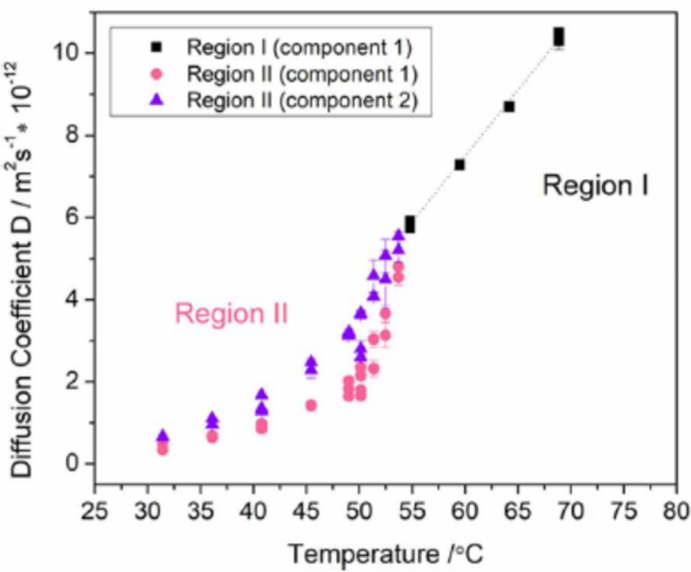
Figure 4. Diffusion coefficients from the hybrid ceramic-polymer electrolyte as a function of tempera- ture as determined by PFG NMR. © Journal of the Electrochemical Society, 2020